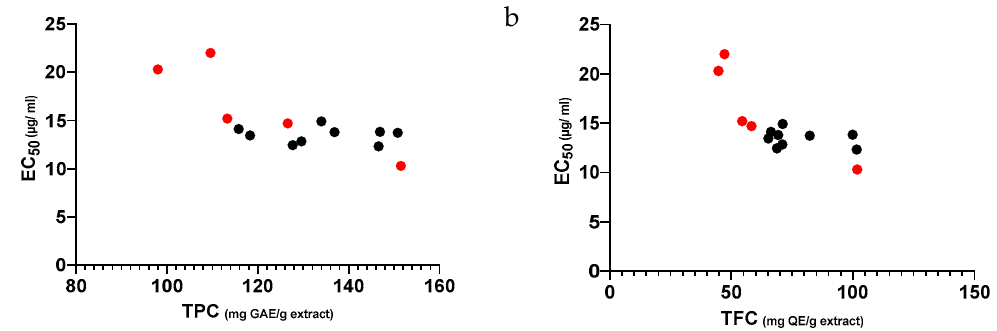
Figure 1. Correlation between antioxidant potential (EC 50 values)) and TPC ( a ) or TFC ( b ) of individual ethanol extracts of propolis from Pereiro ( • ) and of mP.EEs ( • ).